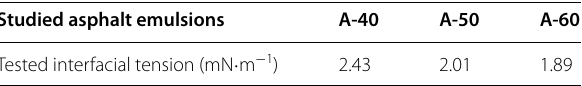
Table 5 Interfacial tension of the studied asphalt emulsions Studied asphalt emulsions